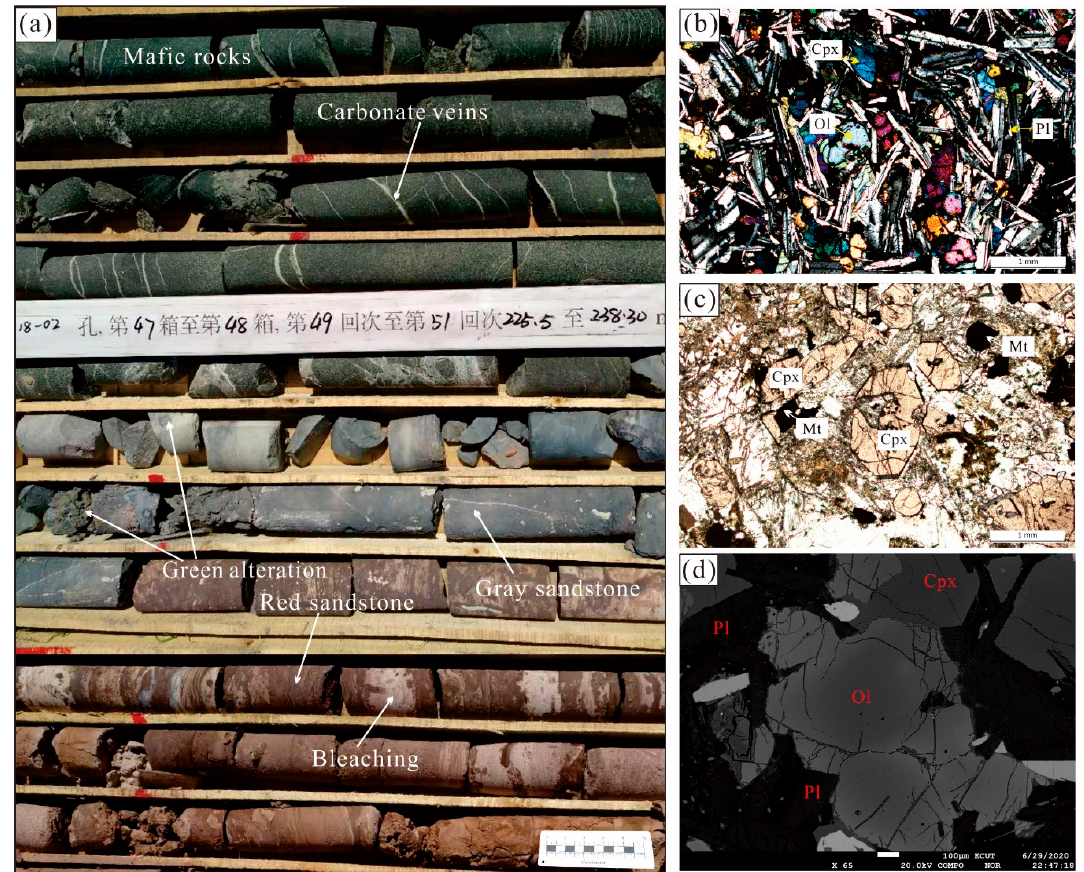
Figure 3. Field photographs and photomicrographs of selected samples from the Cenozoic mafic rocks in the Qianjiadian region. ( a ) Field photographs show the contact relationship of mafic rocks, grey sandstone with green alteration, and secondary reduced (bleaching) white/pink siltstone. ( b ) Microscope photograph of diabases with Ol, Cpx, and Pl. ( c ) Diabases with Mt and Cpx. ( d ) Back scattered electron (BSE) image of diabase with Ol, Cpx, and Pl. Cpx = clinopyroxene; Ol = olivine; Pl = plagioclase; Mt = magnetite.